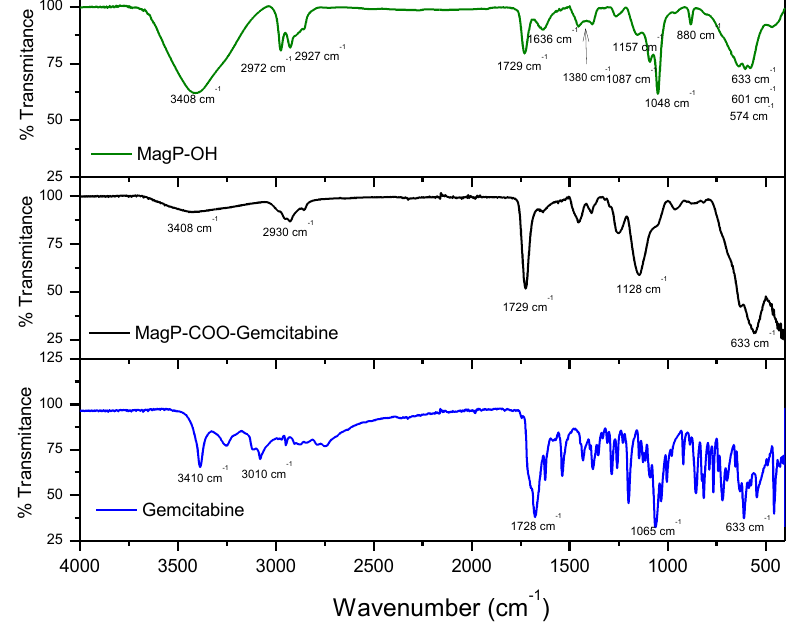
Figure 5. ATR-FTIR spectra of MagP – OH nanoparticles, MagP – COO – GEM nanoparticles, and GEM drug.